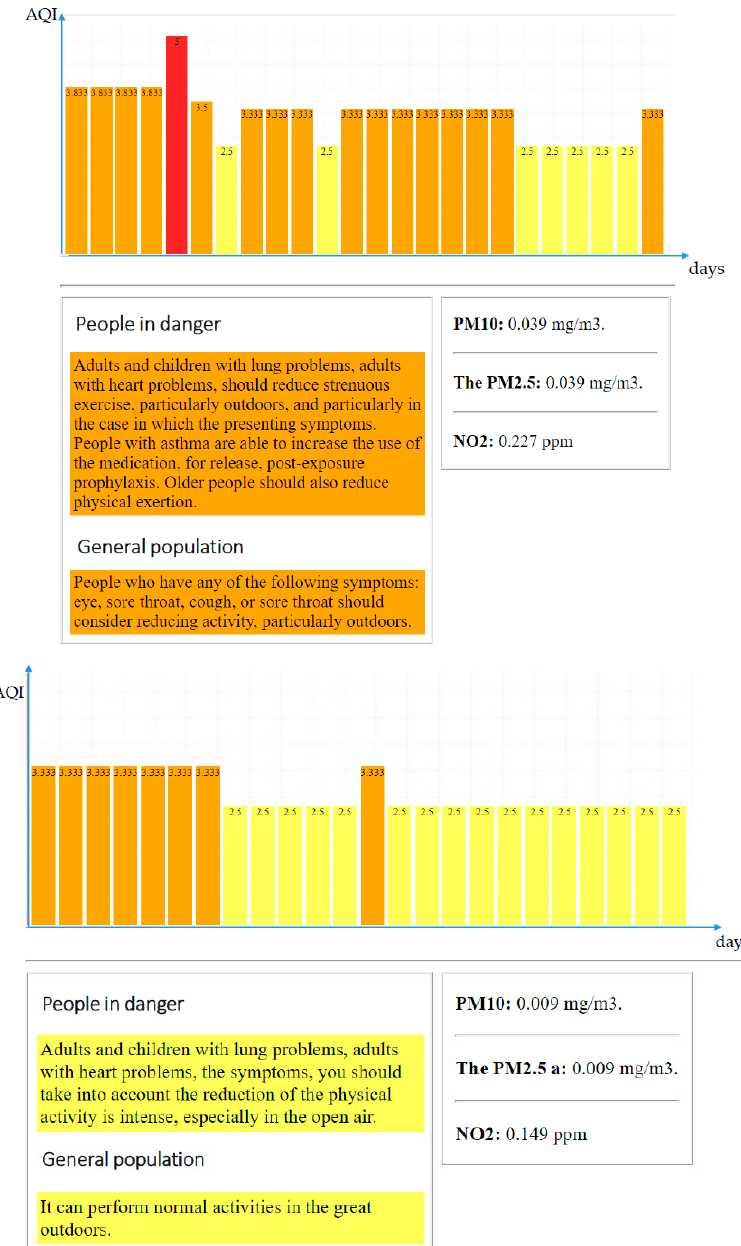
Figure 4. Real-time representation of decision support component for two cases .